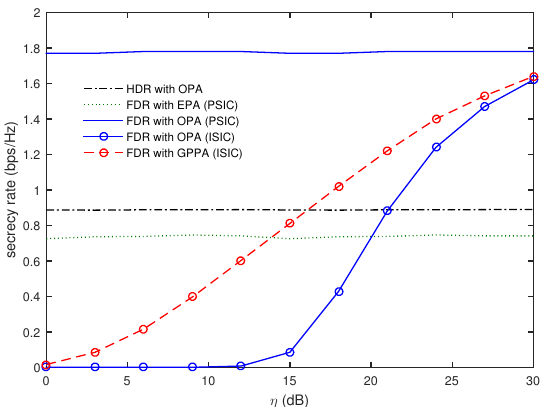
Figure 2. Comparison of secrecy rates as a function of η when T = 4, T E = 1, d Ex = 150 m, d E = 10 m, and P = 60